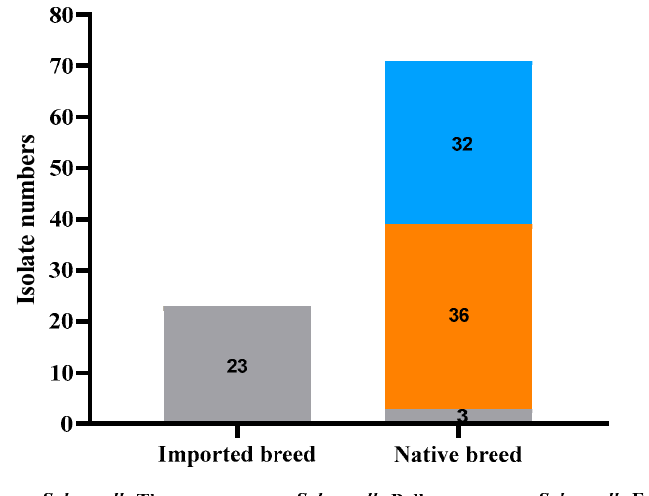
Figure 2. Serotypes of Salmonella enterica isolates ( n = 94) recovered from different chicken breeds.